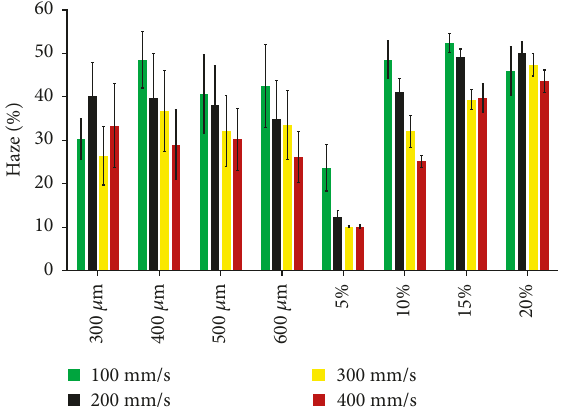
Figure 6: The averaged haze from 400 to 750nm as a function of the scanning speed. The colours relate to the results separated by processing speed: green: 100 mm/s, black: 200mm/s, yellow: 300 mm/s, and red: 400 mm/s. The error bars show the standard error of the